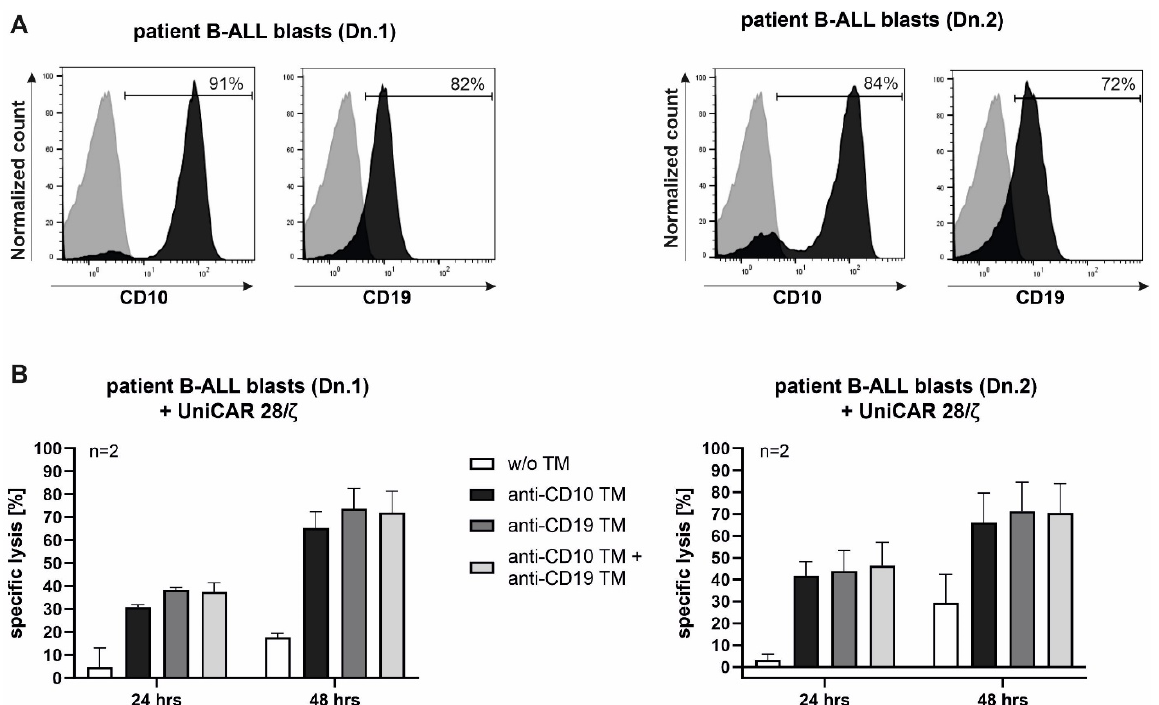
Figure 6. Targeting patient ‐ derived B ‐ ALL blasts with armed UniCAR T ‐ cells. ( A ) Expression of CD10 and CD19 on B ‐ cell acute lymphoblastic leukemia (B ‐ ALL) blasts was detected by flow cytometry after staining with VioBlue ‐ conjugated anti ‐ CD10 or anti ‐ CD19 mAb (dark gray). As a negative control, cells were stained with isotype control (light gray). ( B ) B ‐ ALL blasts were incubated with UniCAR T ‐ cells in the presence of 50 nM anti ‐ CD10 TM, anti ‐ CD19 TM or combination of both TMs at an E:T ratio of 1:1. The viability of ALL blasts was measured using flow cytometry after 24 and 48 h. Results are shown as mean ± SD of two independent T ‐ cell donors for each B ‐ ALL donor (Dn.).